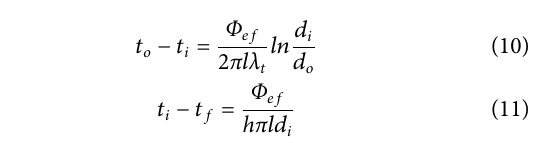
FIGURE 2 | Variation in energy loss for different fl uid velocities.